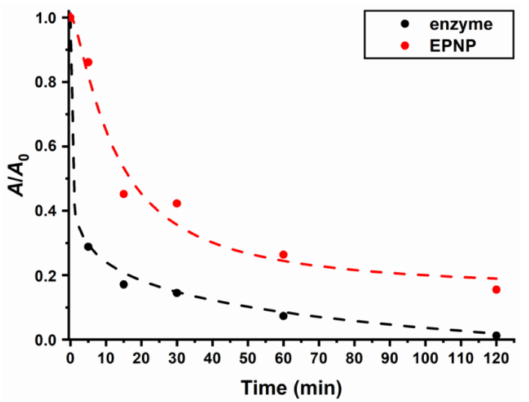
Figure 7. The relative activity of α -chymotrypsin (black) and the CT-P(DEAAm- co -GMA) enzyme– polymer nanoparticle (EPNP) (red) at 25 ◦ C as a function of the time of thermal treatment at 45 ◦